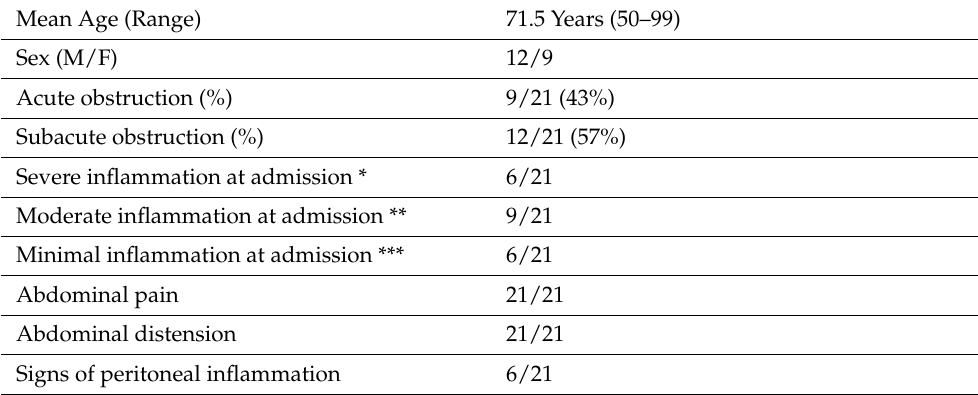
Table 1. Clinical characteristics of 21 patients with colonic obstruction from